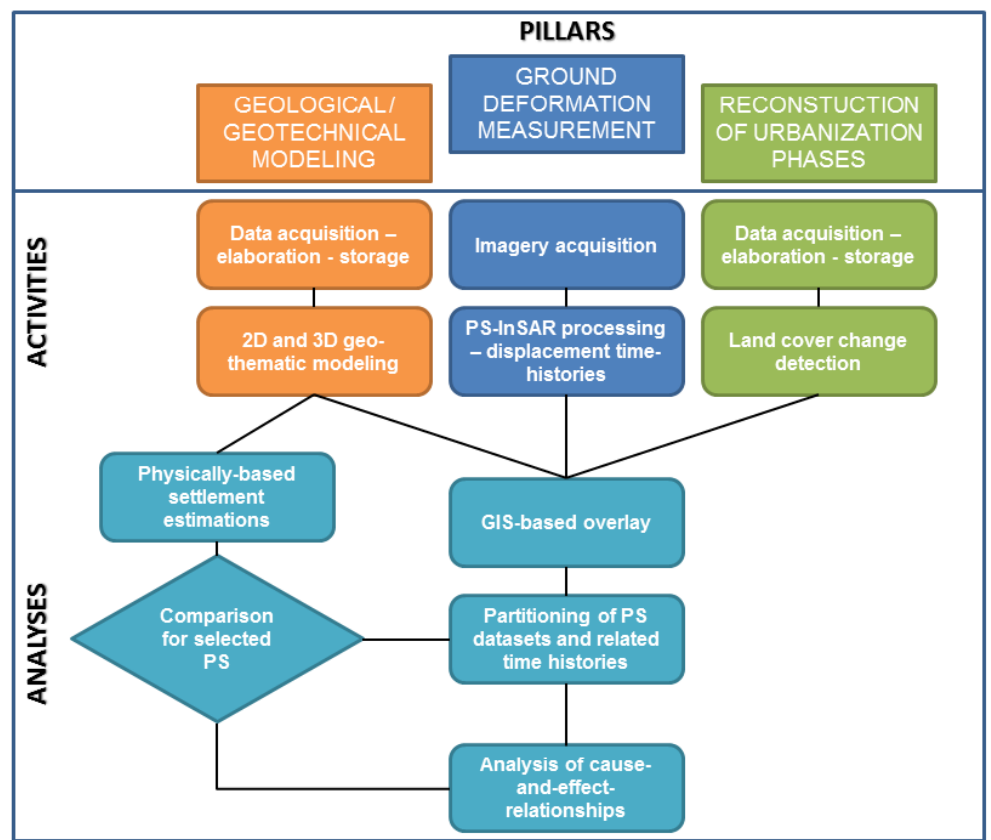
Figure 2 . Workflow of the proposed approach to assessing ground response to urbanisation by combining geological and geotechnical data with satellite interferometric synthetic aperture radar (InSAR) data. PS, Persistent Scatterer; 2D, two-dimensional; 3D, three-dimensional; GIS, geographical information system. Table 1. SAR datasets used in this